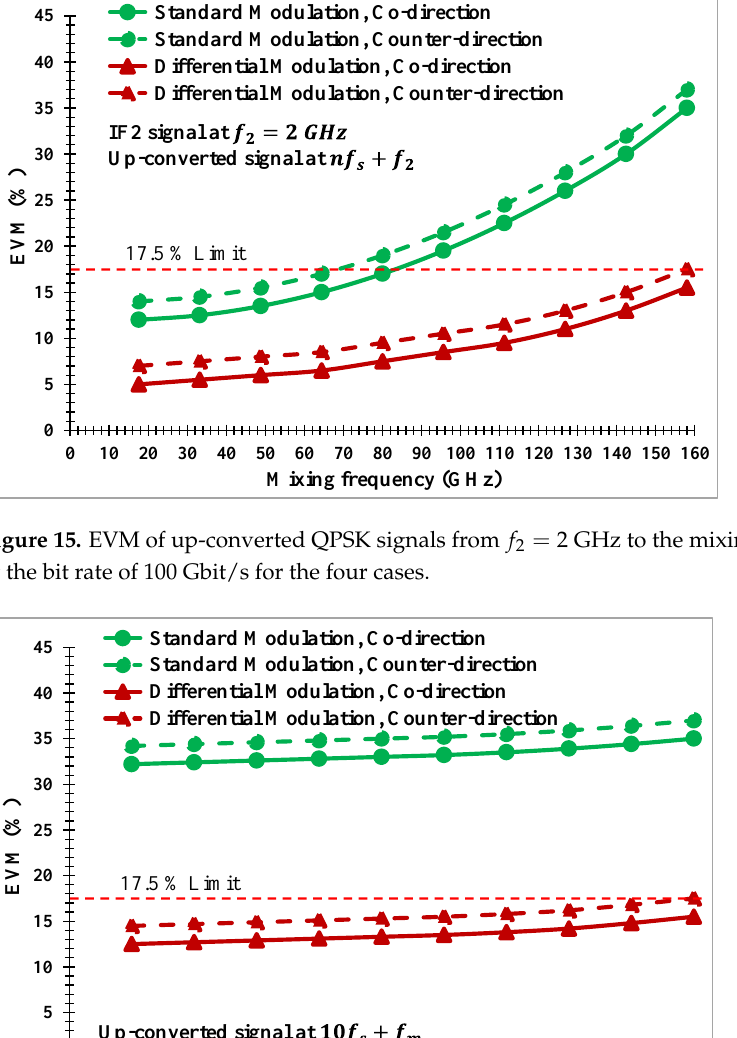
Figure 15. EVM of up-converted QPSK signals from 𝑓 2 = 2 GHz to the mixing frequencies 𝑛𝑓 𝑠 + 𝑓 2 at the bit rate of 100 Gbit/s for the four cases.